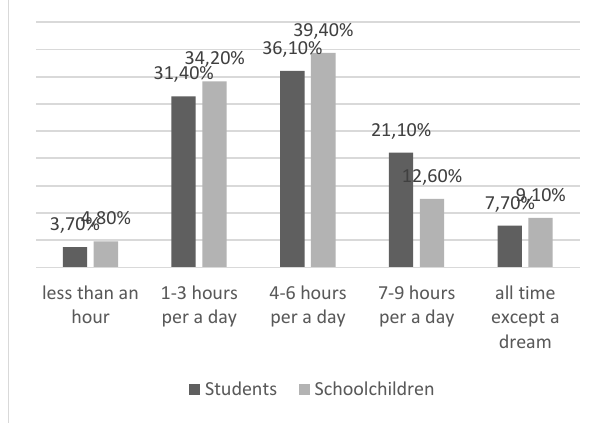
Figure 9. Amount of time spent